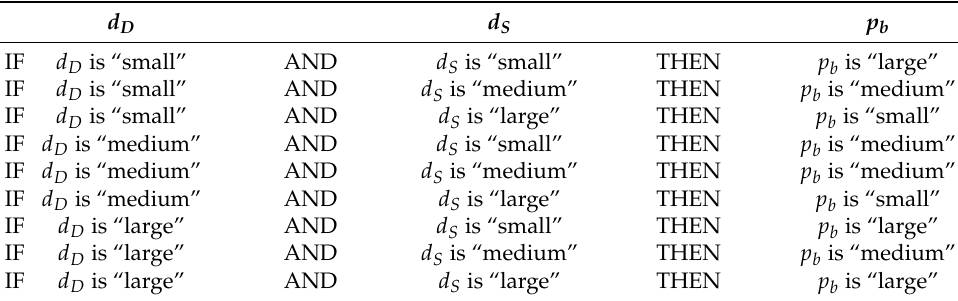
Table 1. Set of fuzzy rules used for bottleneck probability estimation.